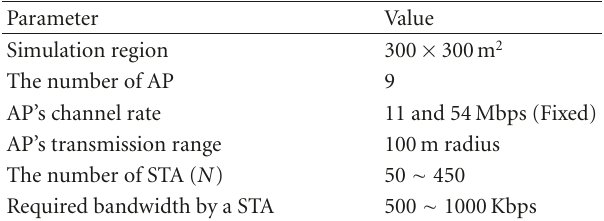
Table 2: Simulation